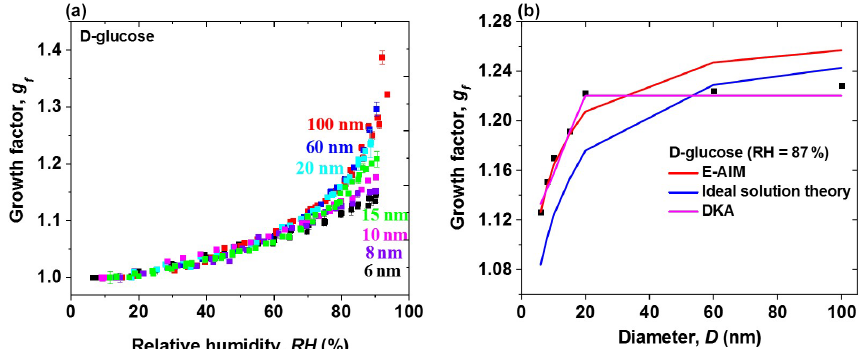
Figure 8. (a) Hygroscopic diameter growth factor ( G f ) of D-glucose nanoparticles with dry diameters of 100nm (red square), 60nm (blue square), 20nm (cyan square), 15nm (green square), 10nm (pink square), 8nm (royal square), and 6nm (black square). (b) Hygroscopic diameter growth factor ( G f , black square) of D-glucose nanoparticles with dry diameters from 6 to 100nm at 87%RH. The measured hygroscopic growth factors of D-glucose nanoparticles with diameters from 100 down to are compared with E-AIM (red line), ideal solution theory (blue line), and DKA prediction (pink line).